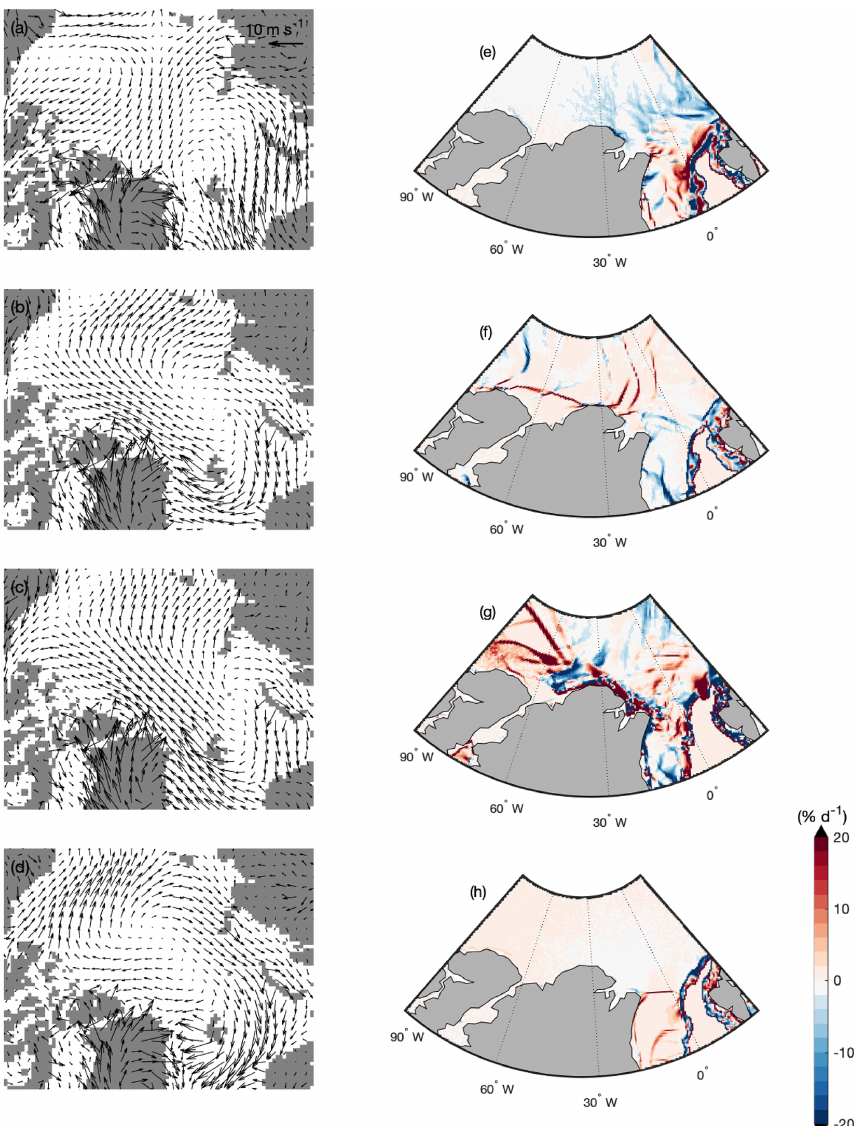
Figure 6. Four major patterns with self-organizing maps (frequency of occurrence as %) of the near-surface 6h wind fields from the RASM simulation during the time periods including before and after the 2018 polynya event: (a) 5–11 February (93%), (b) 15–20 February (83%), (c) 20–26 February (93%), and (d) 3–13 March (95%). The wind vectors were sub-sampled at every three grid cells for a plotting purpose. RASM daily sea ice divergence (%d − 1 ) within each period above is shown on (e) 10 February, (f) 16 February, (g) 24 February, and (h) 4 March